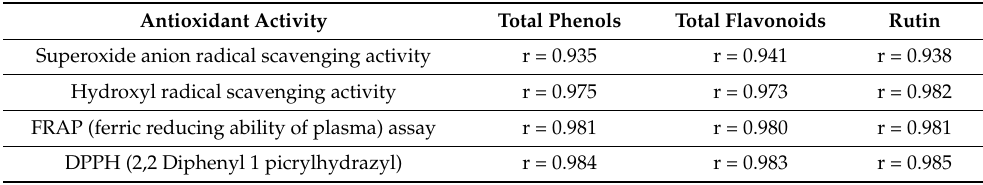
Table 3. Correlation